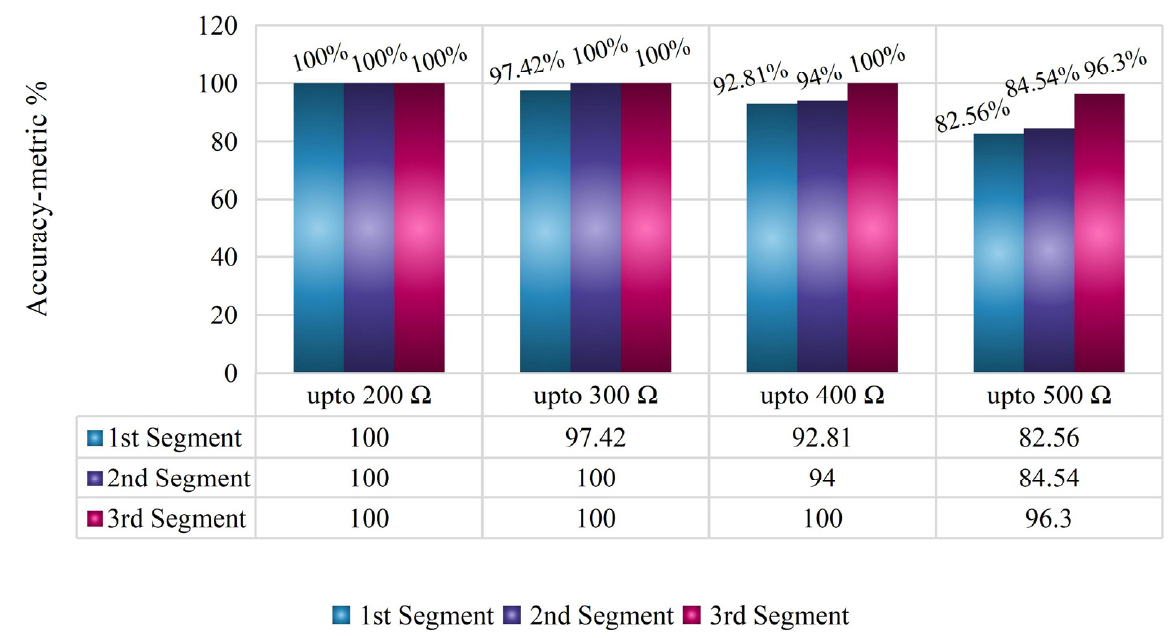
Figure 11. Success rate of ANN under different fault resistances.